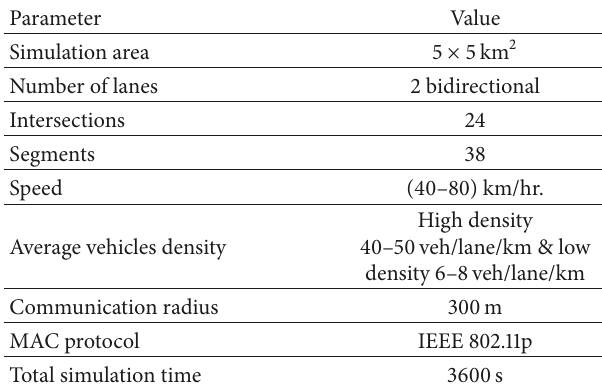
Table 2: Simulation parameters.